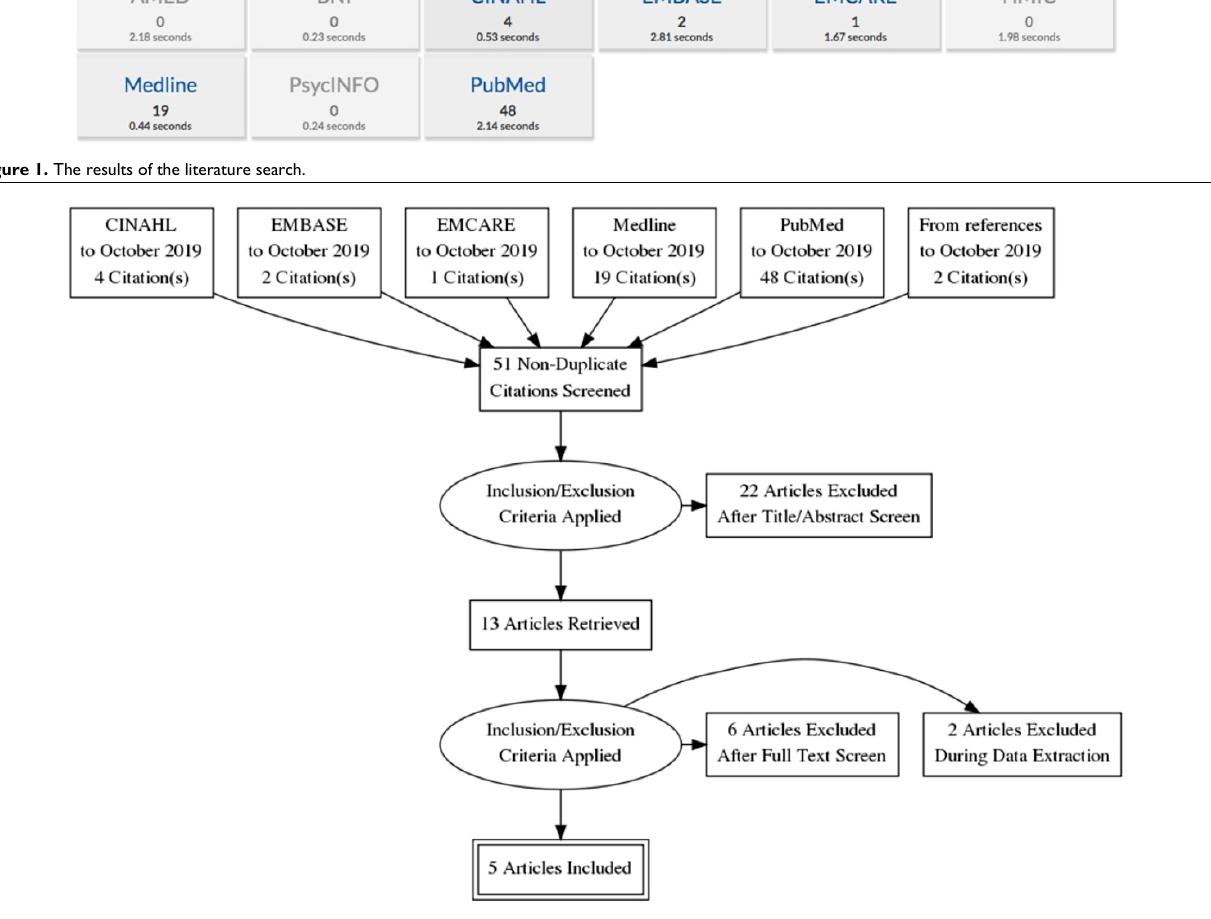
Figure 2. The PRISMA flow diagram.